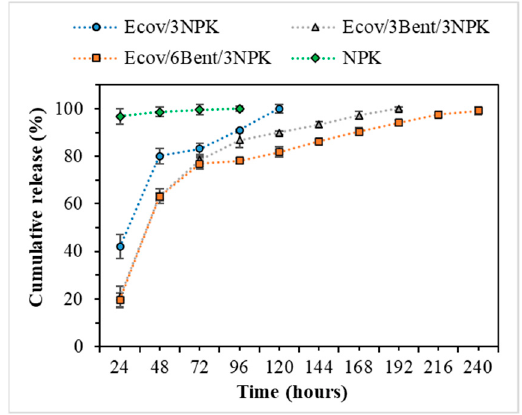
Figure 5. Average NPK release percentage.